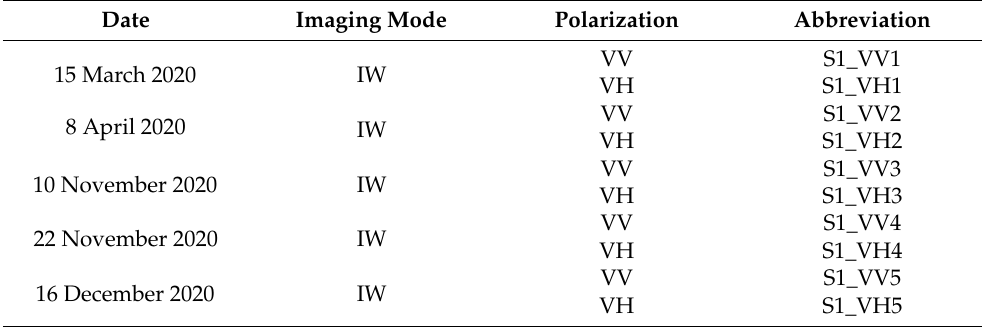
Table 3. The basic information of the multi-temporal Sentinel-1 data used in this